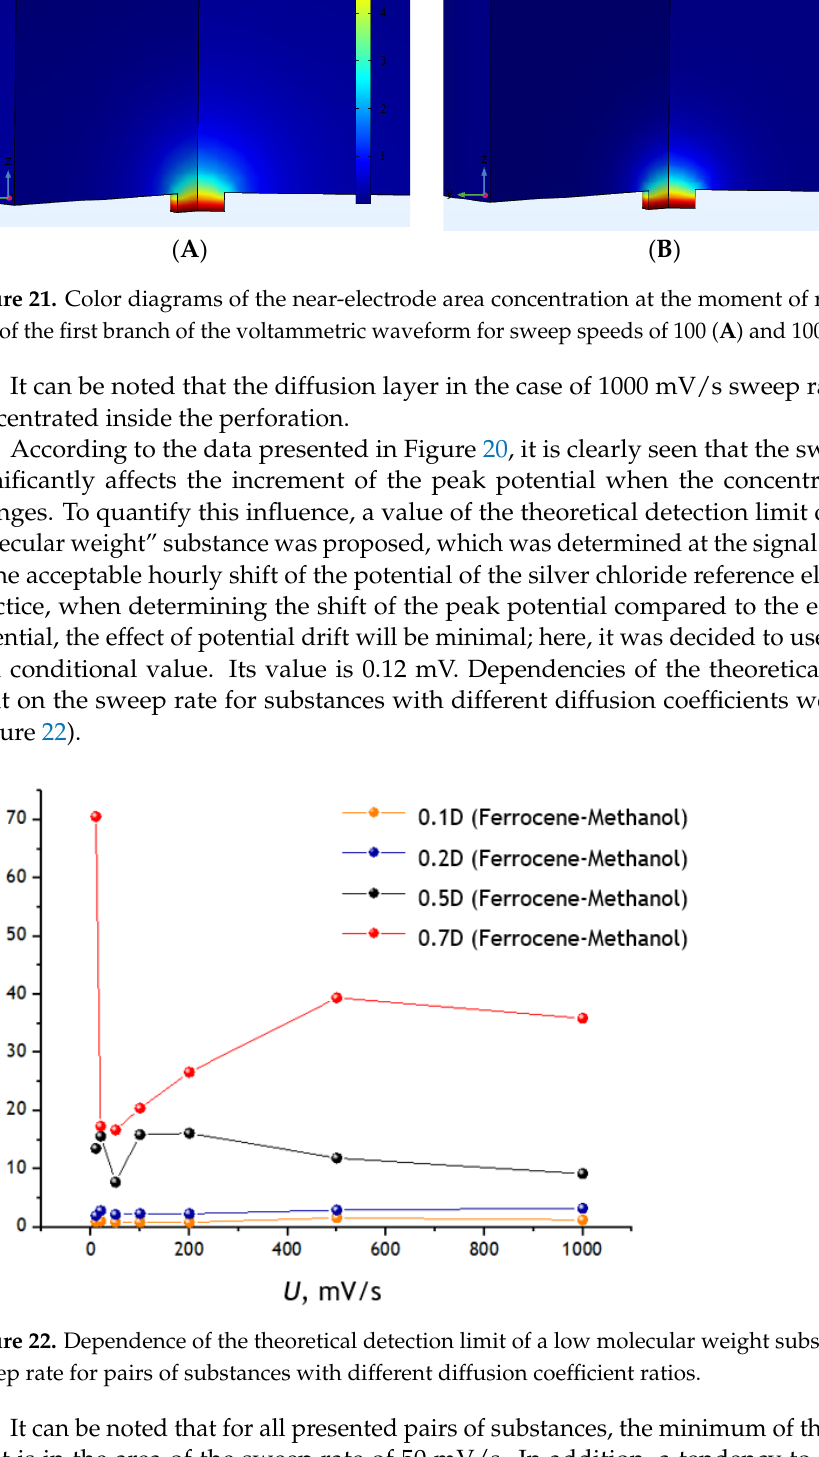
Figure 20. The dependence of the oxidation peak potential on the fraction of a high molecular weight compound for different sweep rates: ( A )—D HMWC = 0.1 × D FeCMeth , ( B )—D HMWC = 0.2 × D FeCMeth,